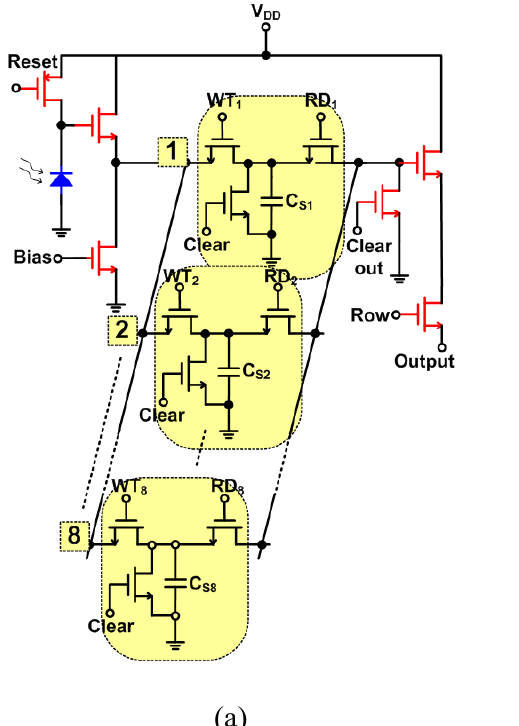
Figure 9. (a) The schematic diagram of the ultrahigh-speed in-situ APS containing 8 memory elements and 38 transistors and (b) the layout screen capture of a single